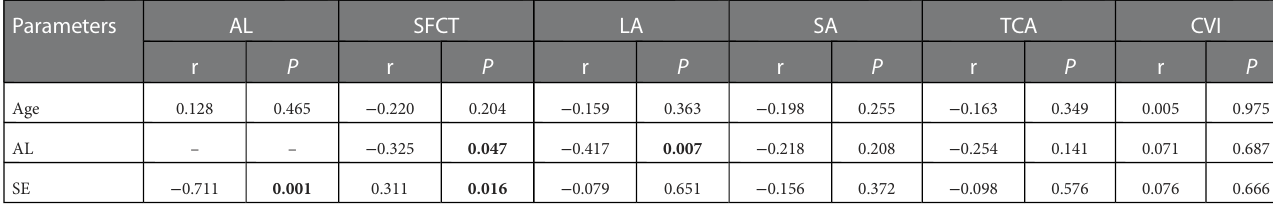
TABLE 3 Correlation between choroid microstructure parameters and other baseline parameters in high hyperopia patients .